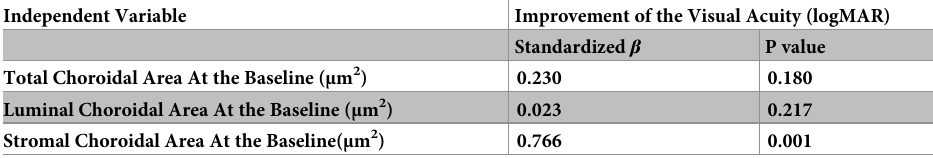
Table 6. Multiple linear regression analysis of amblyopic patient (n = 24). Independent Variable Total Choroidal Area At the Baseline ( μ m 2 ) Luminal Choroidal Area At the Baseline ( μ m 2 ) 0.023 0.217 Stromal Choroidal Area At the Baseline( μ m 2 ) 0.766 0.001 The inter-observer reproducibility of the binarization method was very high with ICC = 0.84 for the total area, 0.82 for the luminal area, and 0.81 for the stromal